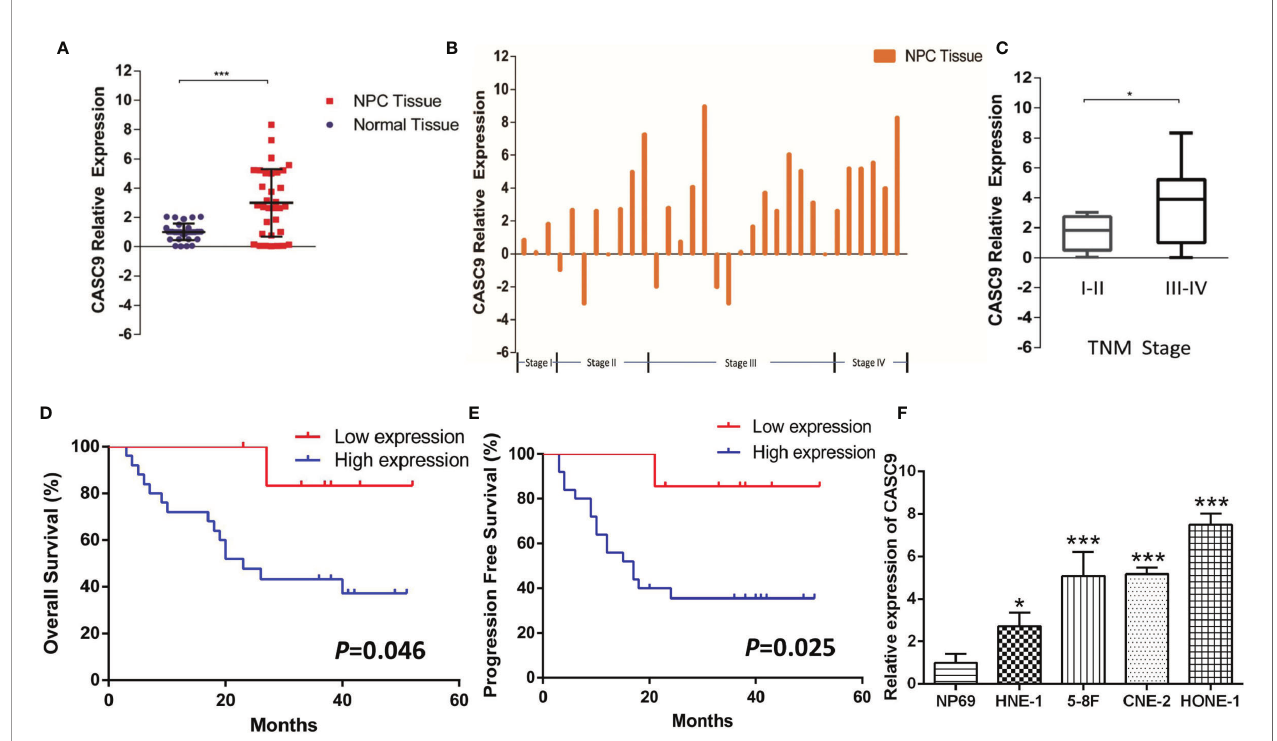
FIGURE 2 | Relative expression of CASC9 in human NPC tissues and cell line. (A, B) CASC9 was up-regulated in NPC tissues compared with corresponding adjacent non-tumor tissues ( P < 0.001). (C) CASC9 in NPC tissues of patients in stage III-IV was signi fi cantly higher than that of patients in stage I-II ( P < 0.05). (D, E) Kaplan – Meier curve of overall survival and progression free survival of NPC patients with high and low CASC9 expression. (F) Expression level of CASC9 in a panel of human NPC cell lines (HNE-1, 5-8F, CNE-2, HONE-1) and normal epidermal cell NP-69. *P < 0.05, ***P <